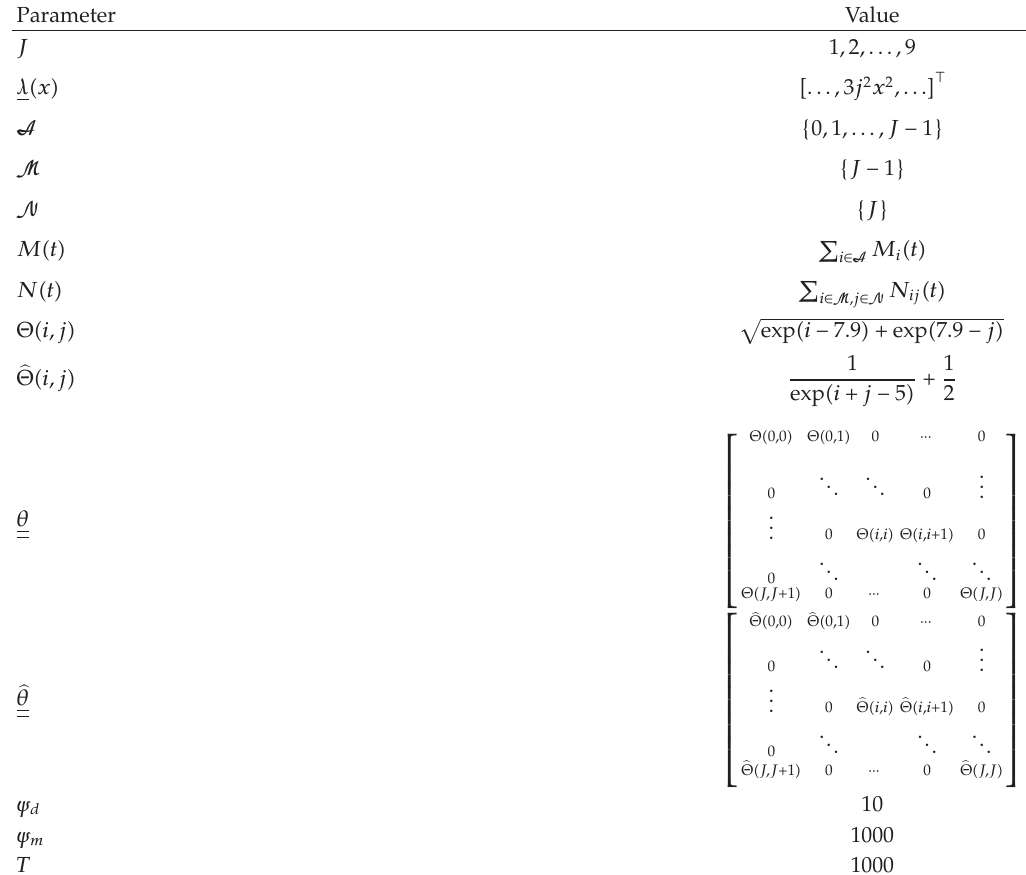
Table 1: Parameters of the numerical